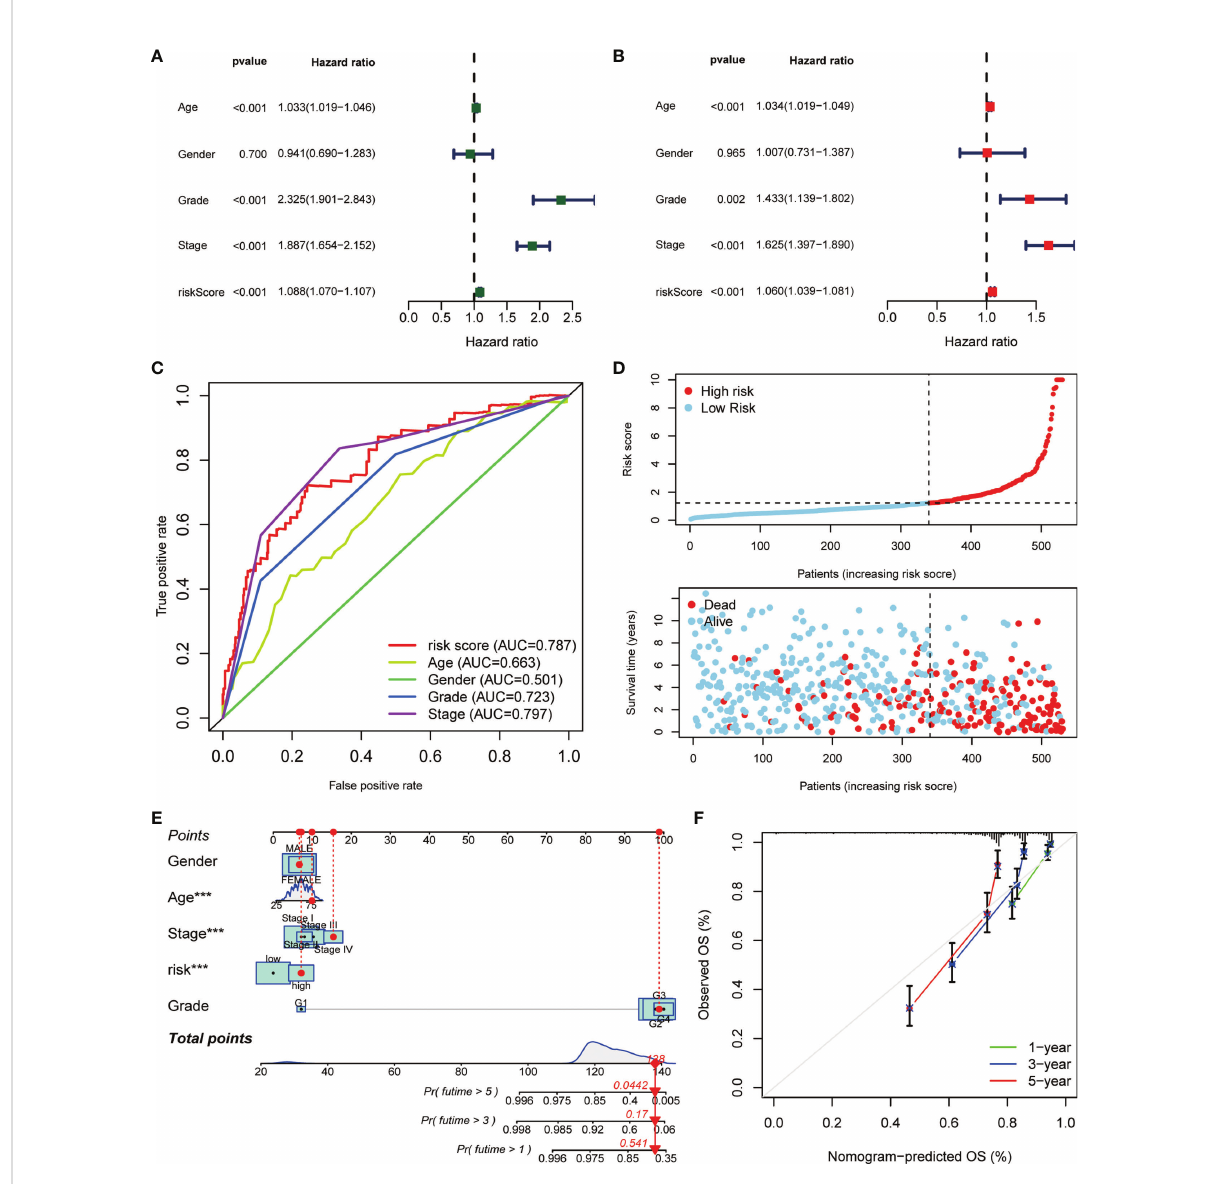
FIGURE 5 The correlation analysis of risk score and clinicopathological variables in ccRCC. The (A) uniCox and (B) multiCox analyses explored the independent prognostic value of risk score and multiple clinical factors. (C) The comparative ROC curves showed that the risk score was superior to most clinical factors in predicting patients ’ long-term survival. (D) Ranked dot and scatter plots showing the risk score distribution and patient survival status. (E) Nomogram combining the risk signature and clinical factors. (F) Calibration curves for the nomogram-predicted OS at 1, 3, and 5 years ( p < 0.001